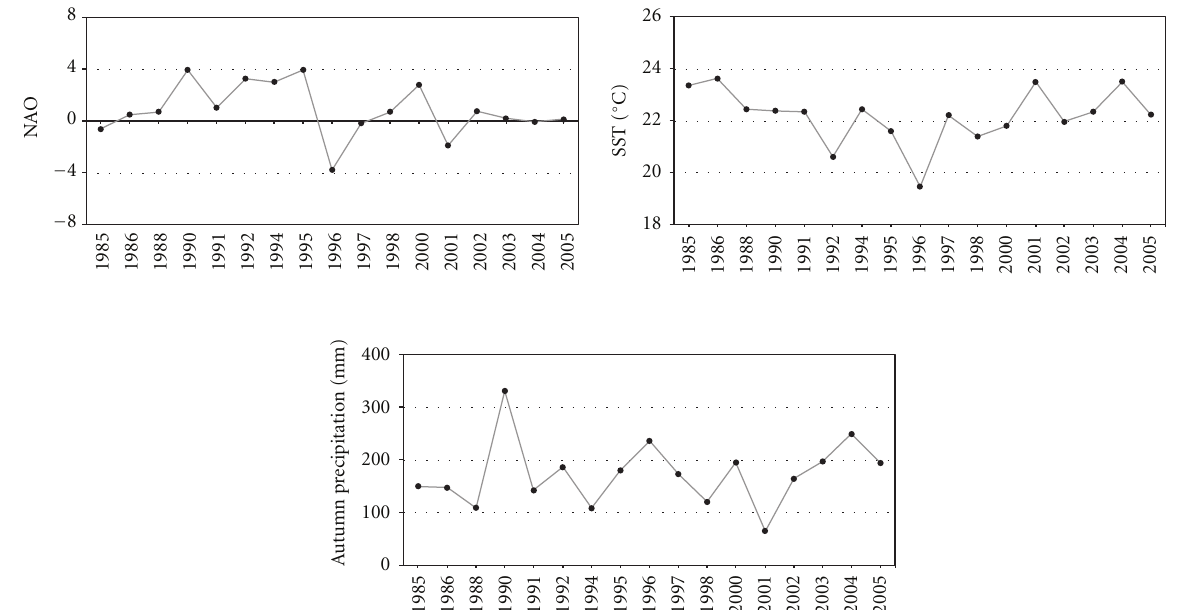
Figure 2: NAO index and Sea Surface Temperature (SST) and autumn precipitation recorded in the period 1985–2005 for the north-western Ionian Sea.